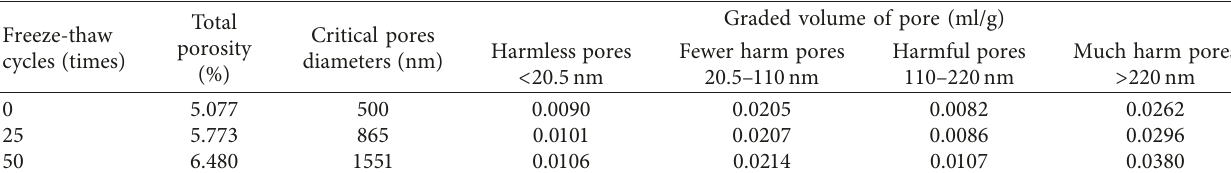
Table 5: Pore structure of cement mortar after various freeze-thaw